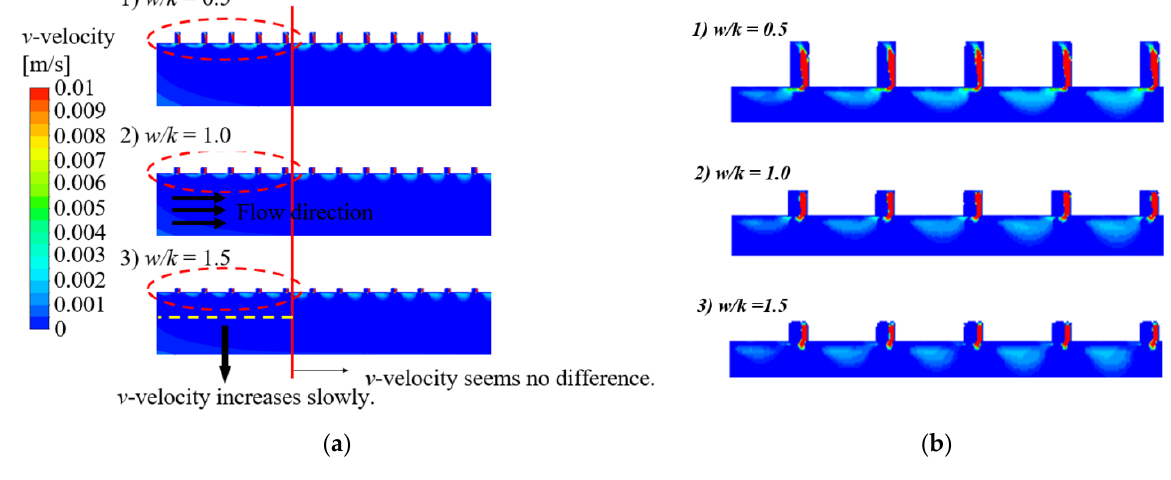
Figure 7. The v -velocity contours for various ratios as a function of w / k at the corrugated pipe; ( a ) The v -velocity contours for the corrugated pipe different w/k , ( b ) The enlarged areas represented as red circle of the groove from 2nd to 5th in pipes.